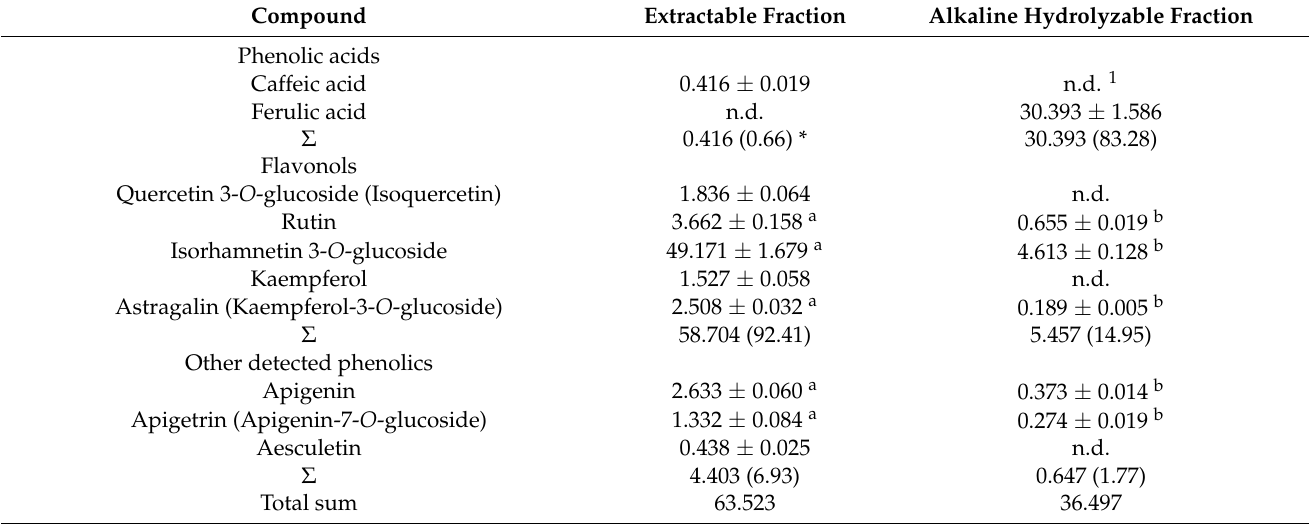
Table 2. Phenolic content (mg/kg dry weight) in bee-collected artichoke